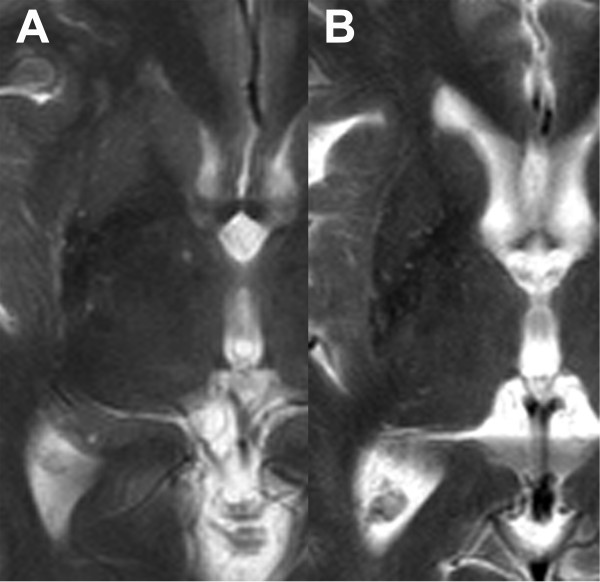
HPR observed in MSA patients. Representative examples of HPR observed in (A) MSA-P (a 61-year-old woman; disease duration = 2 years) and (B) MSA-C (a 66-year-old woman; disease duration = 7 years) patients are shown. In (A), HPR is located predominantly at the posterior part of the lateral margin of the putamen. Moderate hypointensity of the posterior half of the putamen is also seen. Putaminal atrophy is not observed in this case. HPR observed in the MSA-C patient (B) is not easily distinguishable from that of a normal subject (Figure 1C).